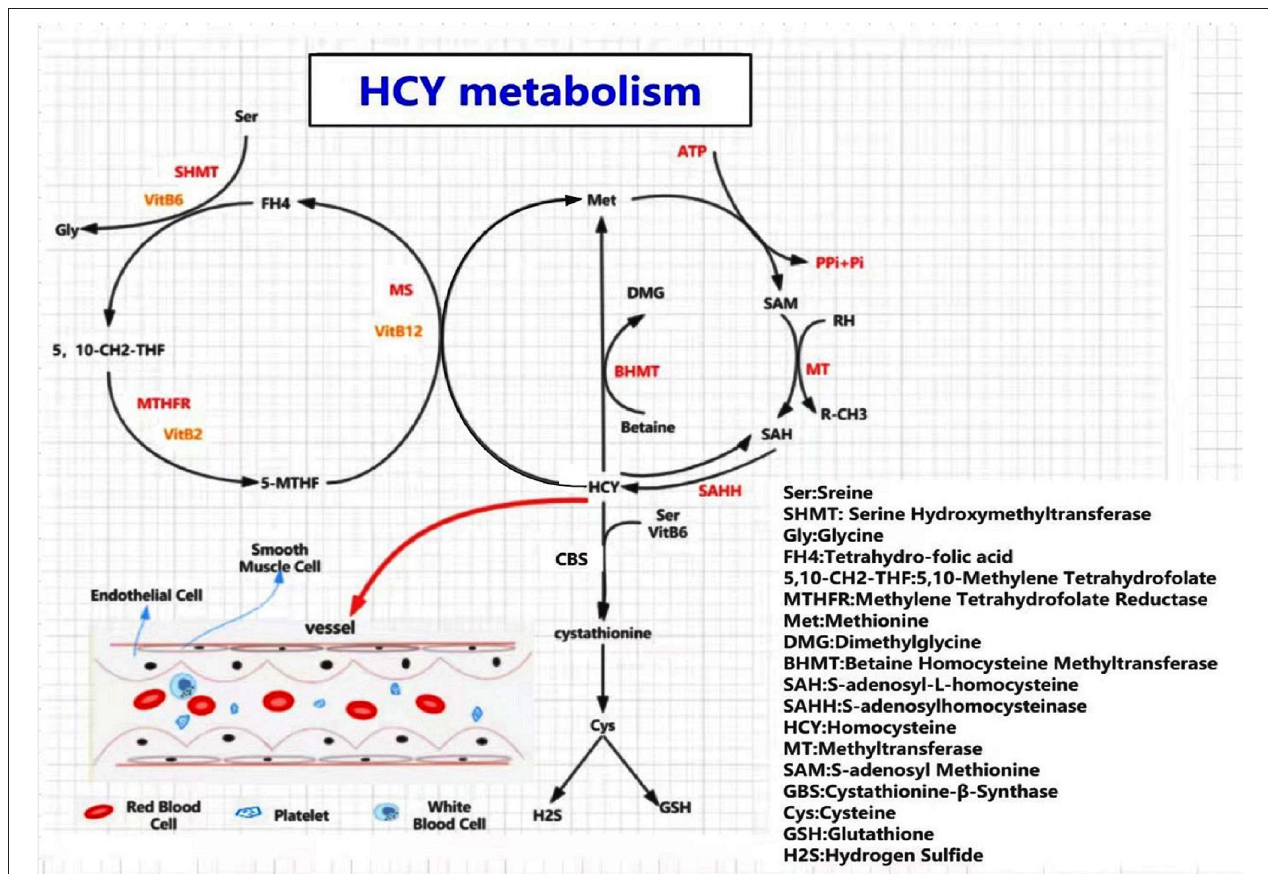
FIGURE 1 | A diagram of homocysteine (Hcy) and methionine metabolism. Three pathways involved in Hcy meatabolism, including remethylation pathway, transsulfuration pathway, and a small amount of Hcy released directly into the extracellular fluid. When a deficiency of MTHFR, CBS, MS, or B-vitamins occurs, an excess of homocysteine enters the blood, causing HHcy, resulting in damage to the corresponding target organs. SAM is the only donor of methyl in all of the metabolic pathways. HHcy leads to hypomethylation of biomolecules, such as proteins, lipids, and nucleic acids, which contributes to metabolic abnormalities and promotes disease